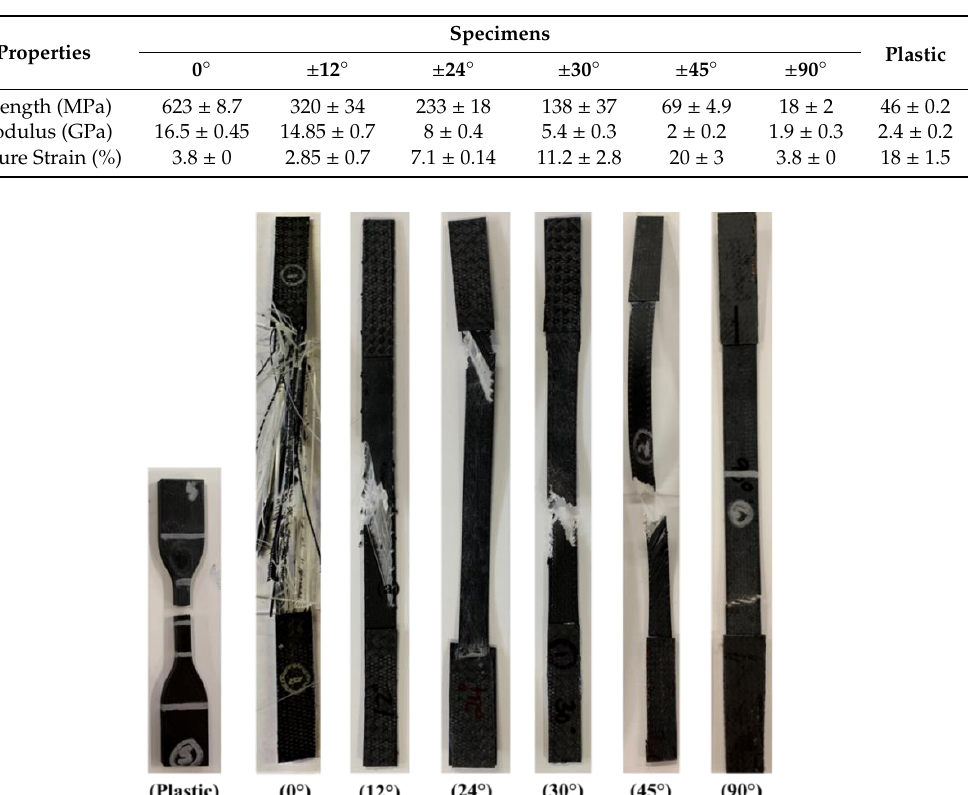
Figure 6. Failure mode for 3D-printed thermoplastic specimen and single-angled 3D-printed GFRP composite specimens (Set 1).